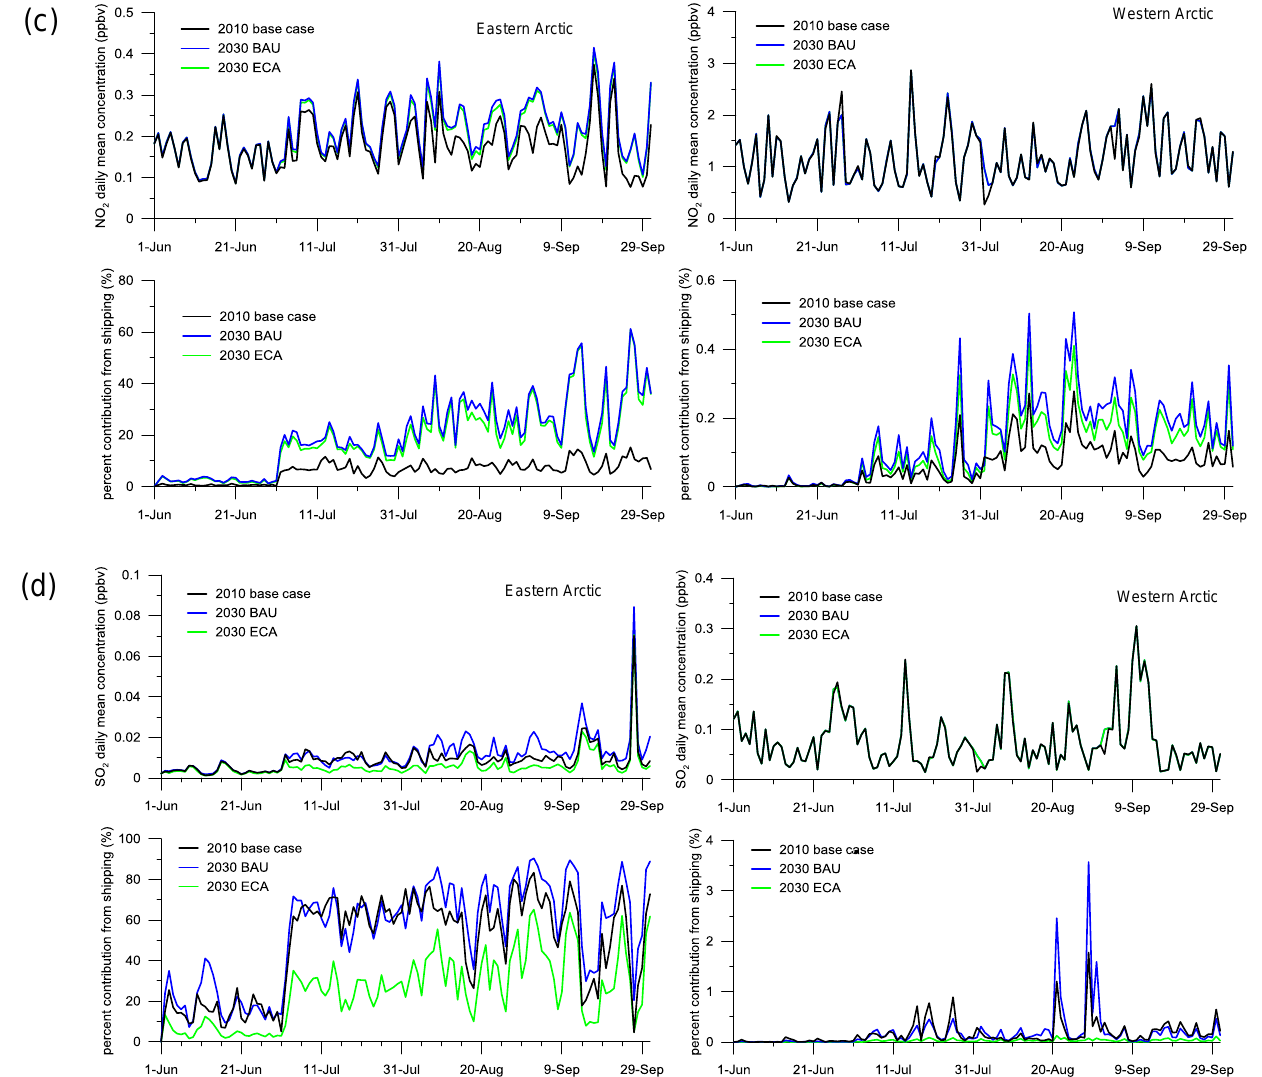
Figure 14. (a) Modelled population-weighted O 3 concentrations (8h daily maximum) over the eastern and western Canadian Arctic (top panels) and contributions from Canadian Arctic shipping emissions (bottom panels). (b) Modelled population-weighted PM 2 . 5 concentrations over the eastern and western Canadian Arctic (top panels) and contributions from Canadian Arctic shipping emissions (bottom panels). (c) Modelled population-weighted NO 2 concentrations over the eastern and western Canadian Arctic (top panels) and contributions from Canadian Arctic shipping emissions (bottom panels). (d) Modelled population-weighted SO 2 concentration over the eastern and western Canadian Arctic (top panels) and contributions from Canadian Arctic shipping emissions (bottom